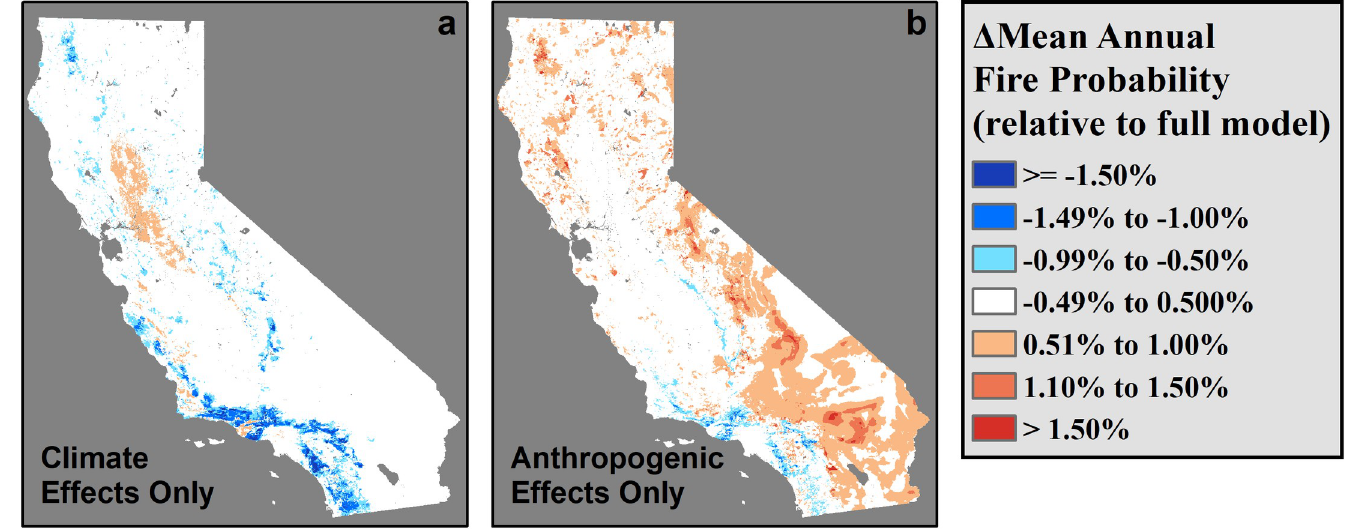
Fig 3. Predicted changes in mean annual fire probability after (a) eliminating the effects of human activity and after (b) eliminating the effects of variation in climate conditions throughout California.